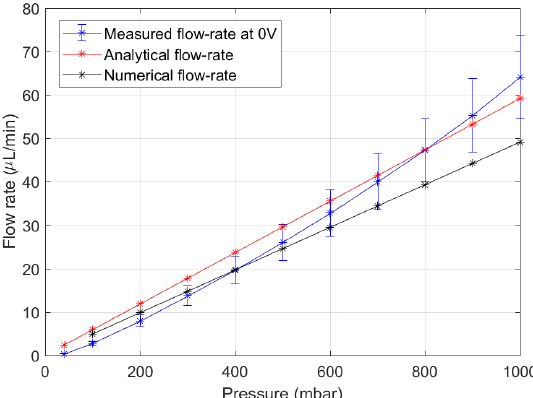
Figure 8. Comparison of predicted and measured flow rate in the microvalve assuming a valving chamber height of 3µm. Error bars indicate one standard deviation of three